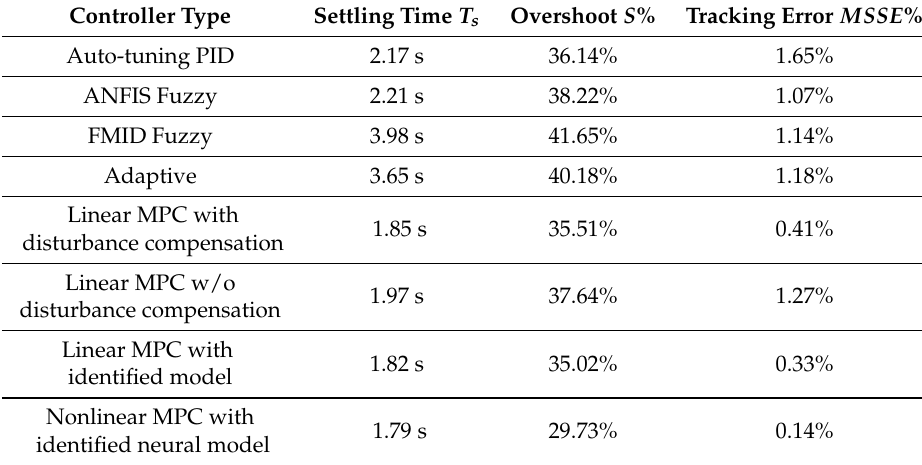
Table 2. Performances with the proposed